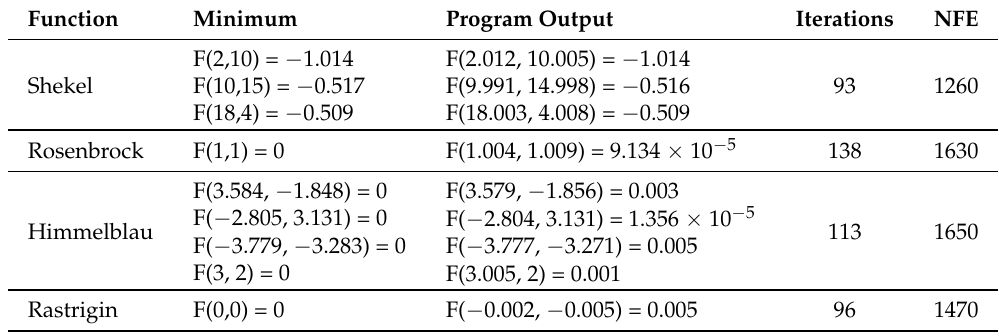
Table 2. A modified bee colony algorithm.